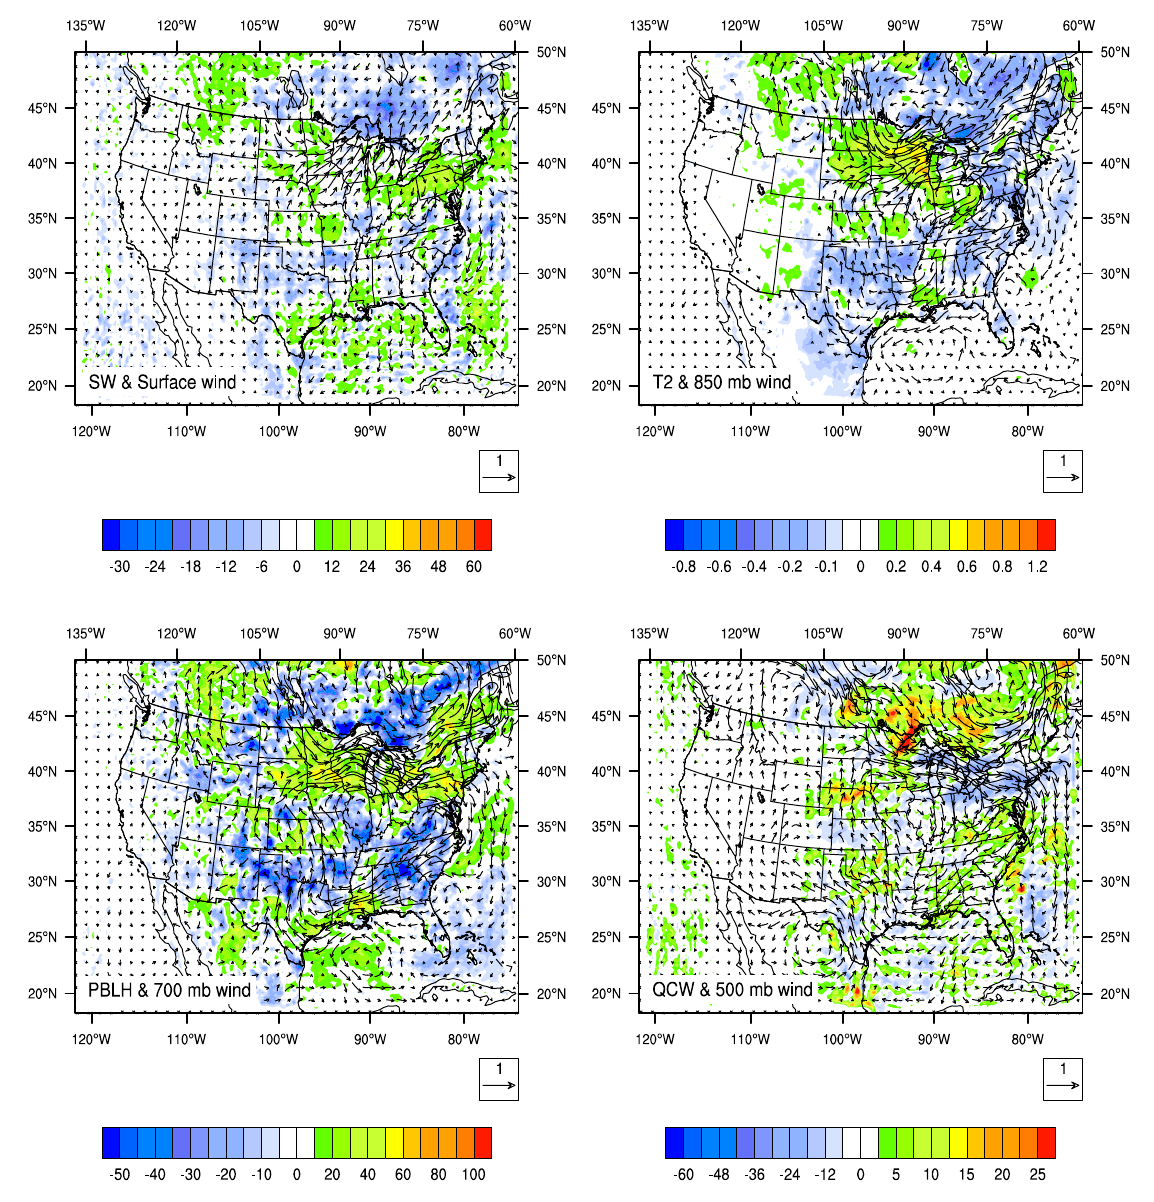
Figure 7. Same as Figure 4 except for changes due to